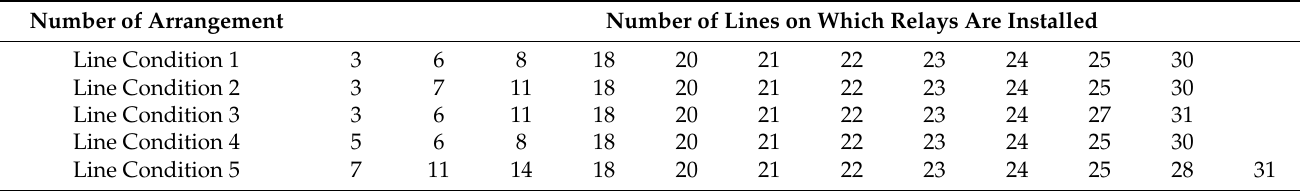
Table 1. Studied condition and number of lines on which relays are installed. Number of Lines on Which Relays Are